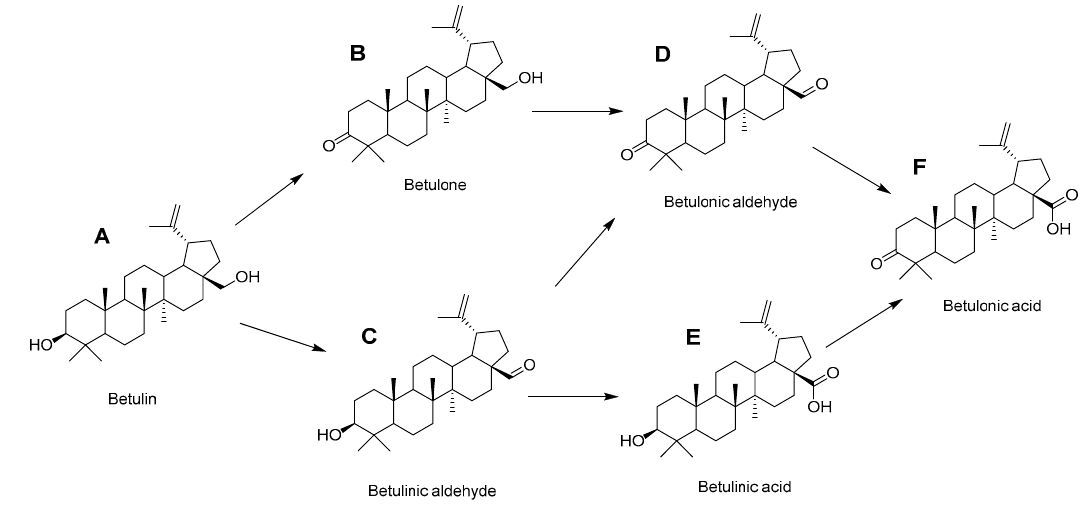
Figure 3. Kinetics of betulin oxidation over different silver catalysts, data are presented taking into account the mass